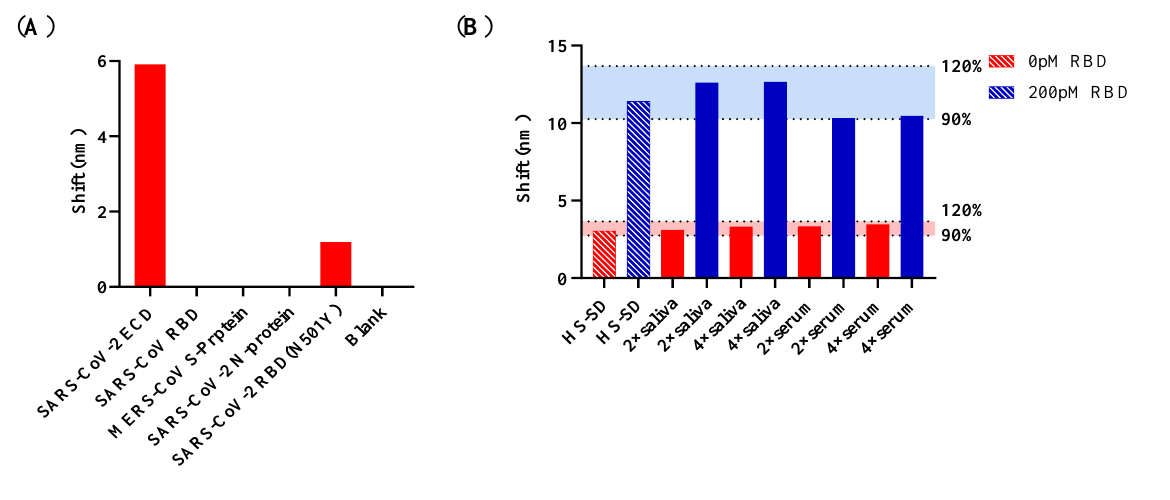
Figure 3. Evaluation of the cross-reactivities and the effect of sample matrix for the AMEC-based FO-BLI biosensors. ( A ) Evaluation of the assay cross-reactivity towards SARS-CoV, SARS-CoV-2, and MERS; ( B ) Evaluation of the effect of dilution of serum and saliva on RBD measurement.